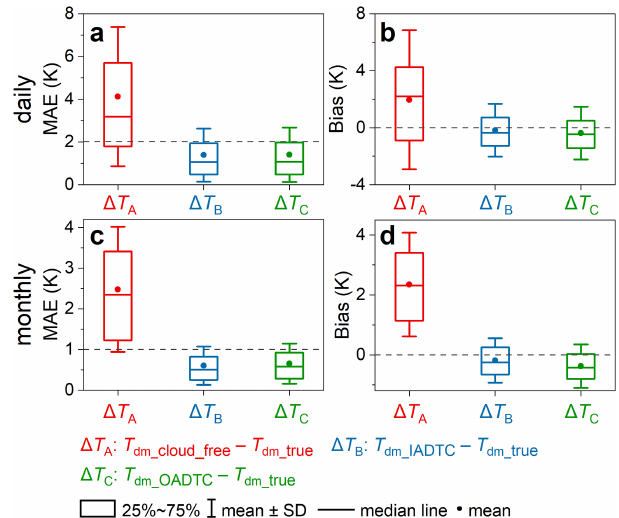
Figure 6. Validations of daily mean LST ( T dm ) estimation with SURFRAD data. Box plots show the errors for the traditional T dm estimation method ( T dm_cloud_free ), the IADTC framework ( T dm_ATC_DTC ), and the OADTC framework ( T dm_OADTC ). Panels (a) and (b) display the MAE and bias at the daily scale, respectively, and panels (c) and (d) display the MAE and bias at the monthly scale,